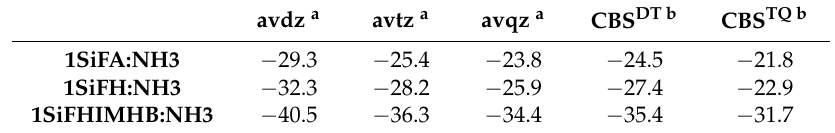
Table 1. Binding energies (E b ), in kJ · mol − 1 , of 1SiF:NH 3 complexes at the MP2 computational level with different basis sets including extrapolation to the complete basis set limit (CBS) with two different basis set pairs.